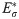
Time of first (orange) and seventh (purple) extinction in the consumer-resource model with adaptive metabolic strategies and with Eσ* drawn independently of δσ.We used m = 10, p = 3 and Eσ*=Qσδσ with Qσ drawn from a normal distribution with mean 〈Q〉 and standard deviation Σ; see S1 Text for more details on the parameters used. The extinction times were computed as the instants at which the densities of the species fell below 1 cell/mL. Both axes are in logarithmic scale, the error bars represent one standard deviation across 50 iterations of the model and the dashed lines are the best power-law fits. The behavior of the extinction times suggests that if Σ = 0 then all species could coexist indefinitely. Indeed, it is possible to show analytically that when Qσ=Q∀σ, all species coexist at the stationary state of the system (see S1 Text for details). The green points show, for comparison, the time of first extinction for a system with the same parameters but where metabolic strategies are fixed. As we can see, even when each species has its own CTR, Qσ, using dynamic metabolic strategies increases by several orders of magnitude the length of the time interval over which species manage to coexist. The results shown do not change noticeably if the initial conditions on the populations are increased, even if by some orders of magnitude.